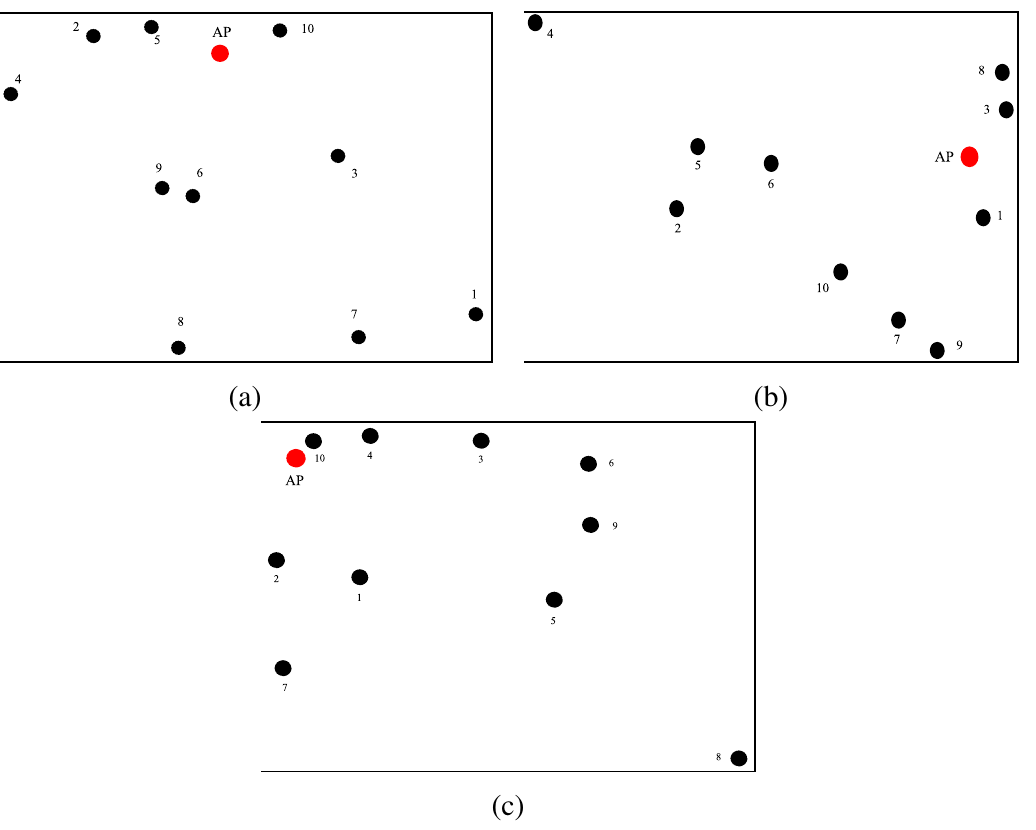
Figure 5. Network topologies with N = 10 nodes randomly deployed over a 10 m 2 square surface, used for (a) PER comparison and (b) evaluation of the network lifetime. (c) Network topology with N = 10 nodes randomly deployed over a 50 m 2 square surface, used for the evaluation of the network